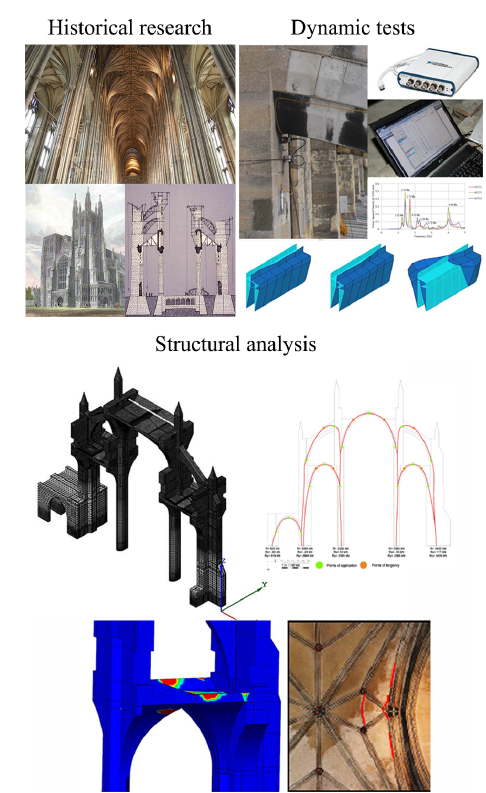
Figure 6. Conservation of cultural heritage buildings, methodology and application to case studies: Cathedral of Canterbury in the UK [13].